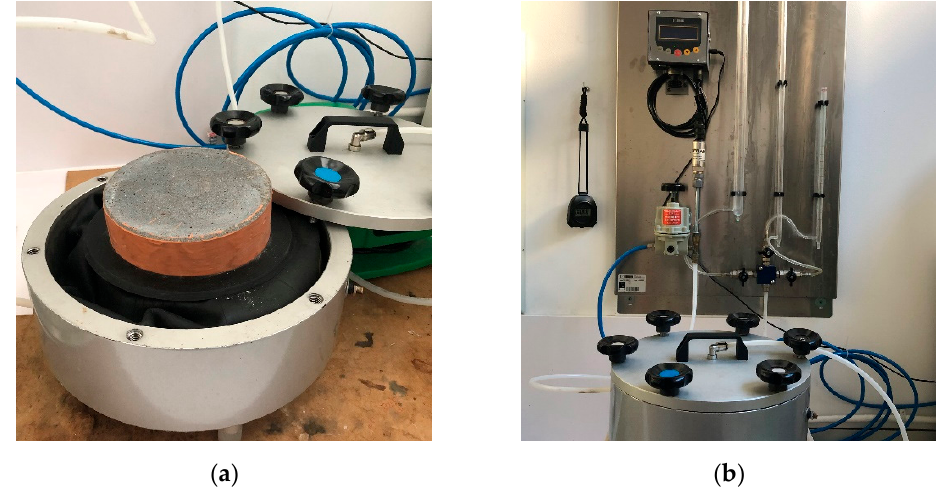
Figure 3. Gas permeability set up: ( a ) Specimen in the permeability cell; ( b ) Permeameter.